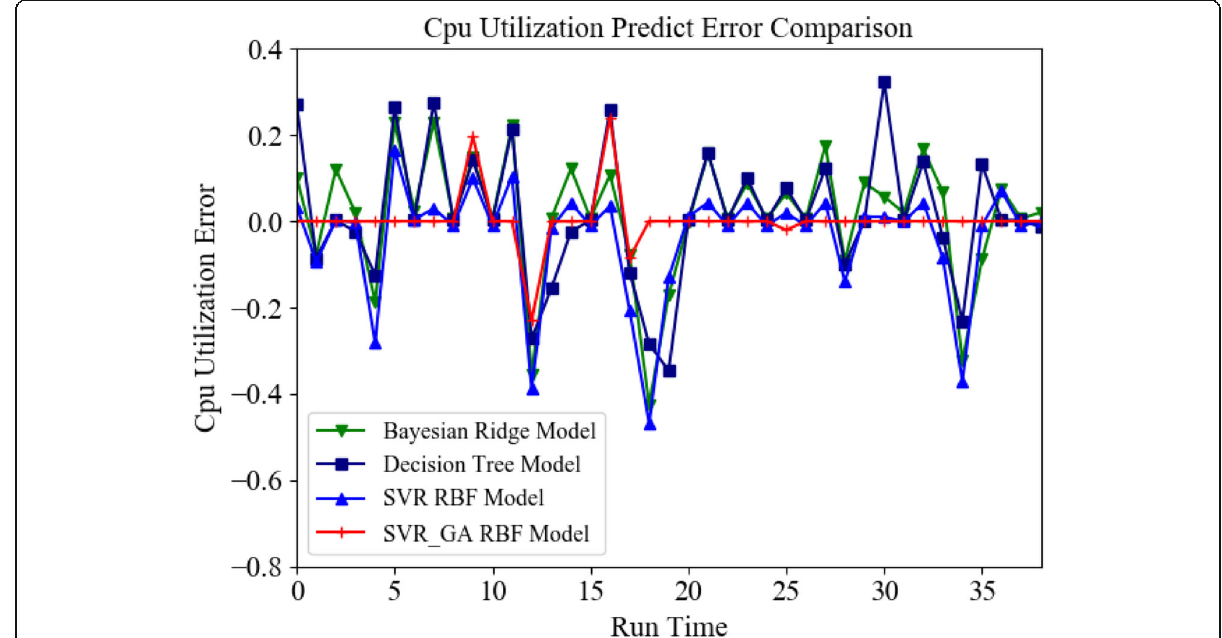
Fig. 3 Comparison of server load prediction errors